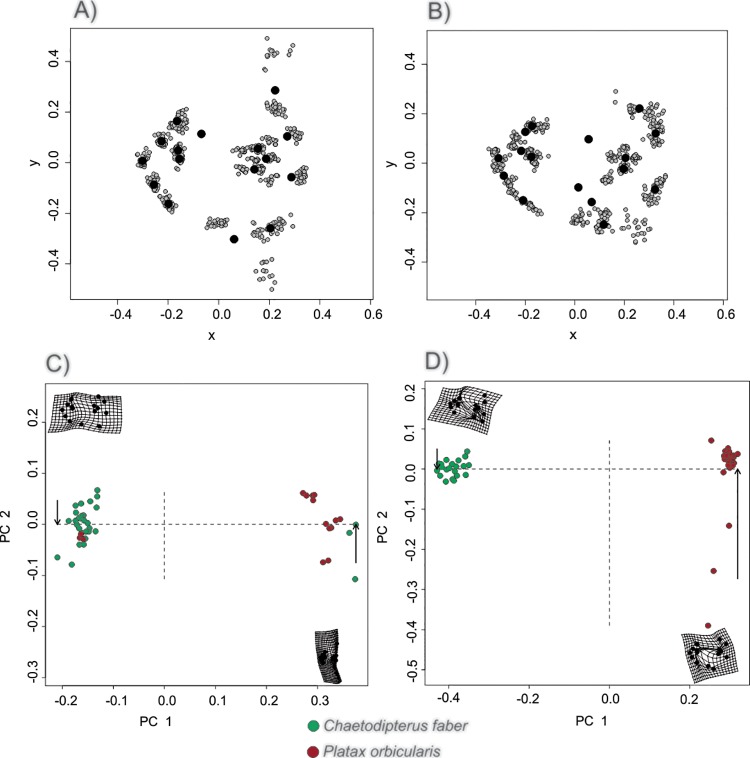
Comparative shape analysis of C. faber and P. orbicularis.General shape variations between mimetic and non-mimetic stages for C. faber and P. orbicularis, where A) are mimetic individuals of both species and B) are non-mimetic individuals of both species, as analyzed bythe Generalized Procrustes Analysis (GPA). Grey dots represent individual values and black dots represent mean values. Principal Components Analysis (PCA) for mimetic individuals; C) presents a clear distinction in general body shape (small and round in C. faber; small and oblong in P. orbicularis (90.73% variance covered by PC1, 2.74% variance covered by PC2), while PCA of non-mimetic individuals of both species; D) shows a tendency to develop a rounded body shape, with greater variation due to inclusion of some elongated individuals (91.03% variance covered by PC1, 4.40% variance covered by PC2). In both cases, green dots represent C. faber and red dots, P. orbicularis.